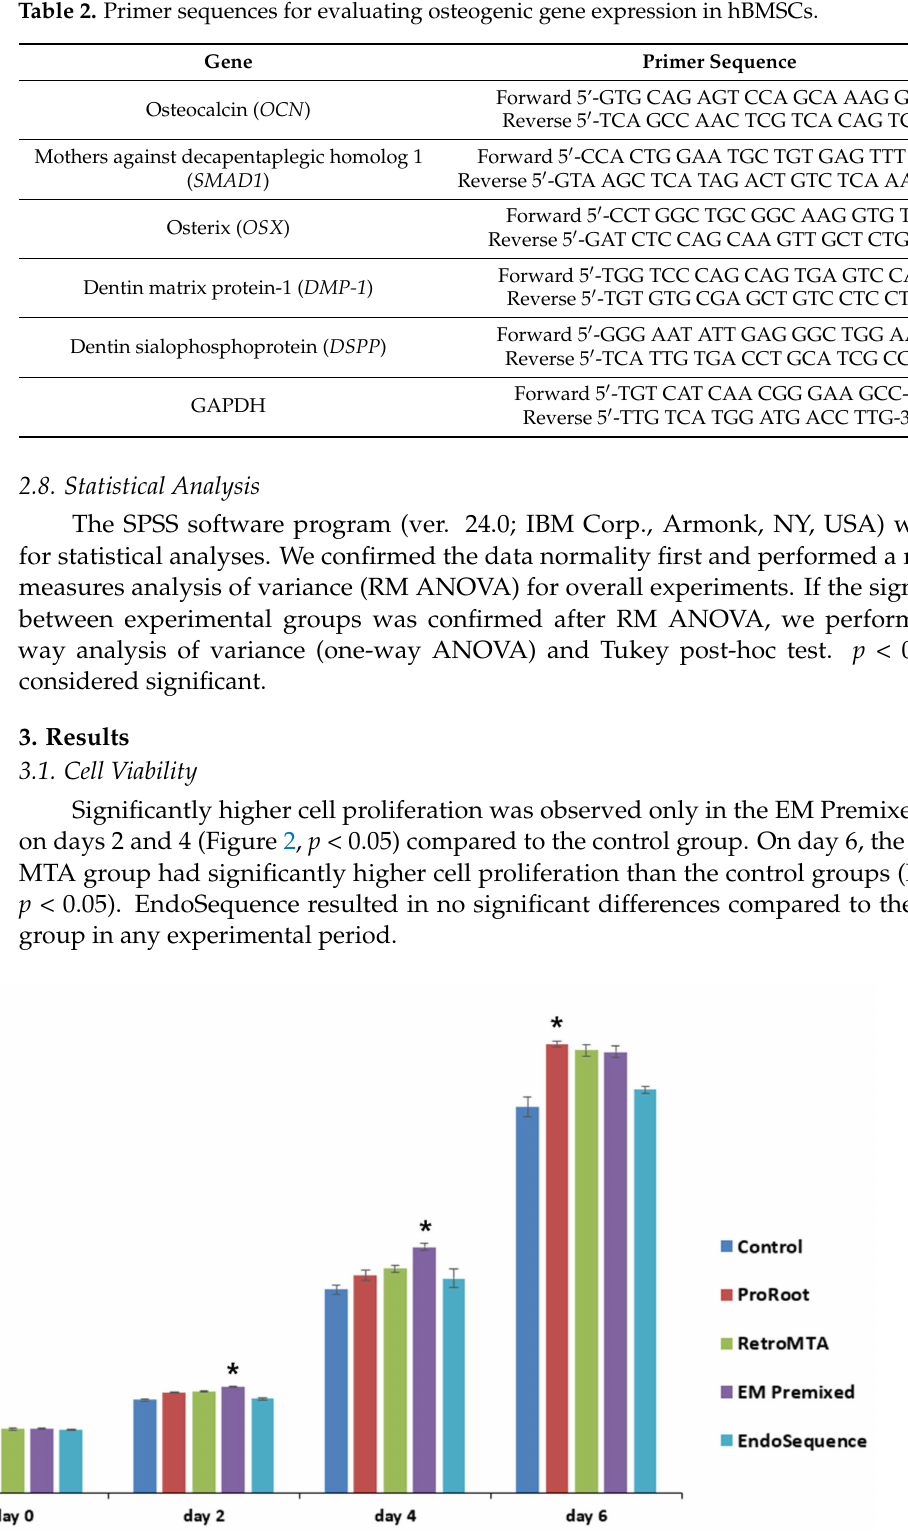
Figure 2. Comparison of cell viability by experimental cement. * p < 0.05 compared to the control group at each time point. Error bars mean standard